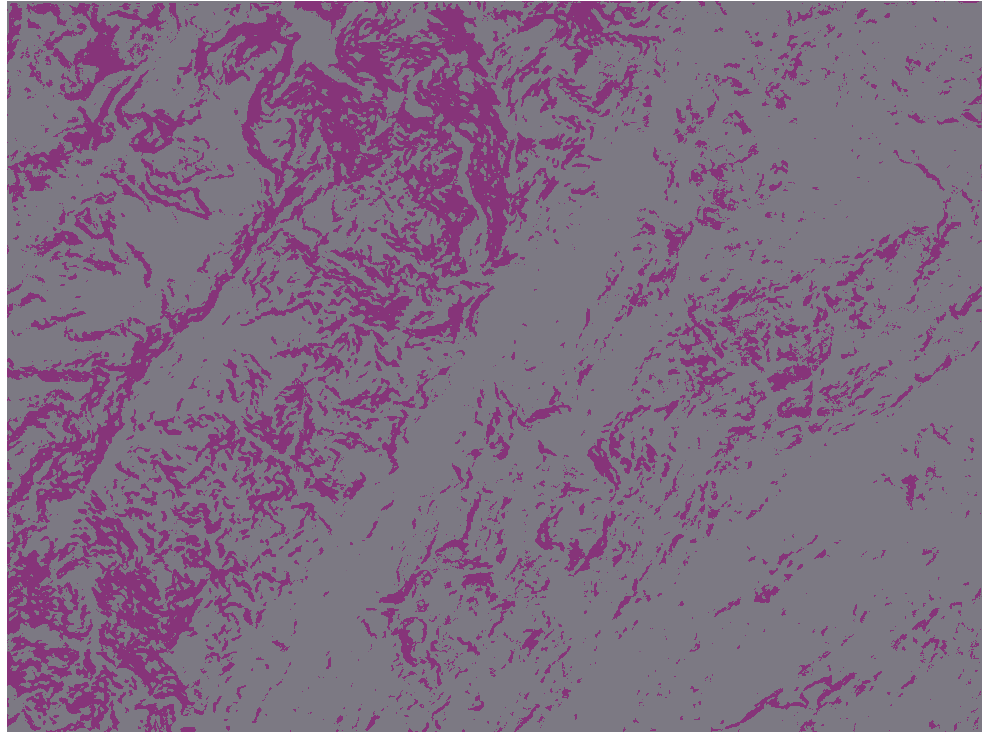
Figure 10. Example of a landslide susceptibility inventory using the proposed model for the study area. Purple: high susceptibility, Gray: moderate